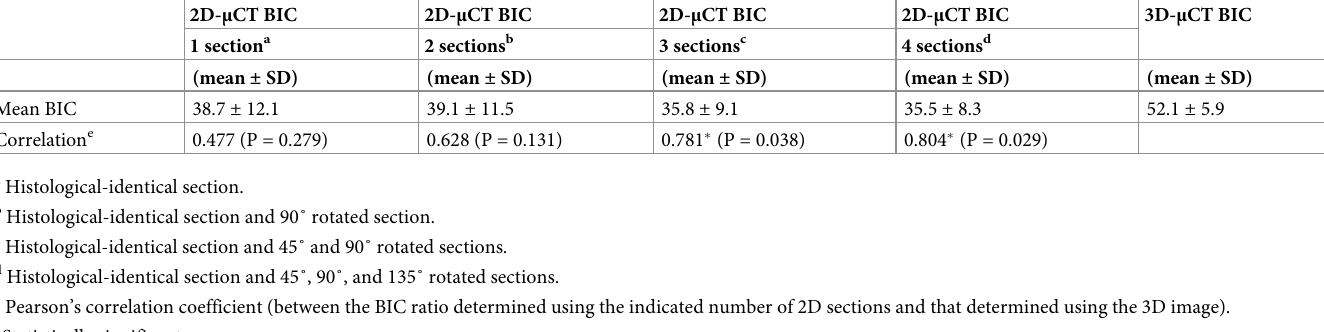
Table 2. BIC ratios determined using the indicated numbers of 2D- μ CT sections, and the correlations between them and the BIC ratio determined using 3D- μ CT images. 2D- μ CT BIC 2D- μ CT BIC 2D- μ CT BIC